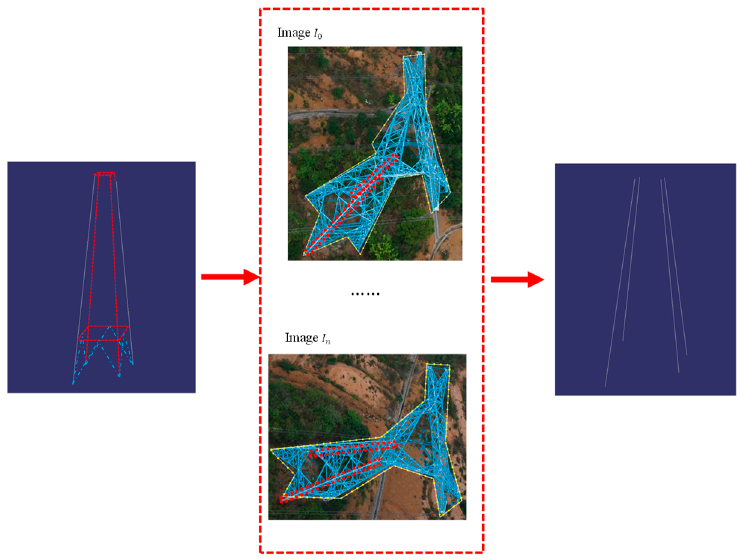
Figure 9. The workflow of the rest of the pylon leg matching.